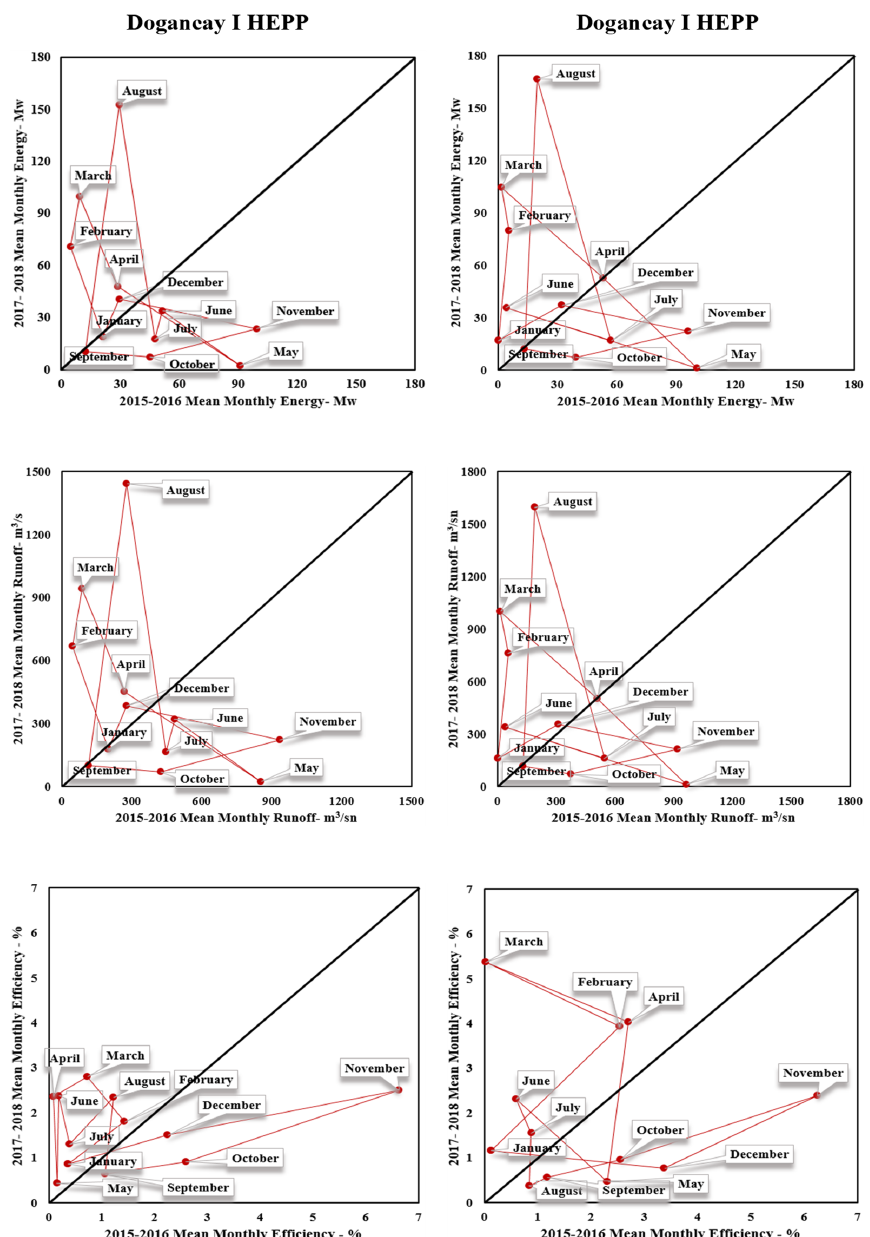
Figure 7. IPTA Method Graphs of Standard Deviation Analysis Results of Dogancay I and II HEPPs.